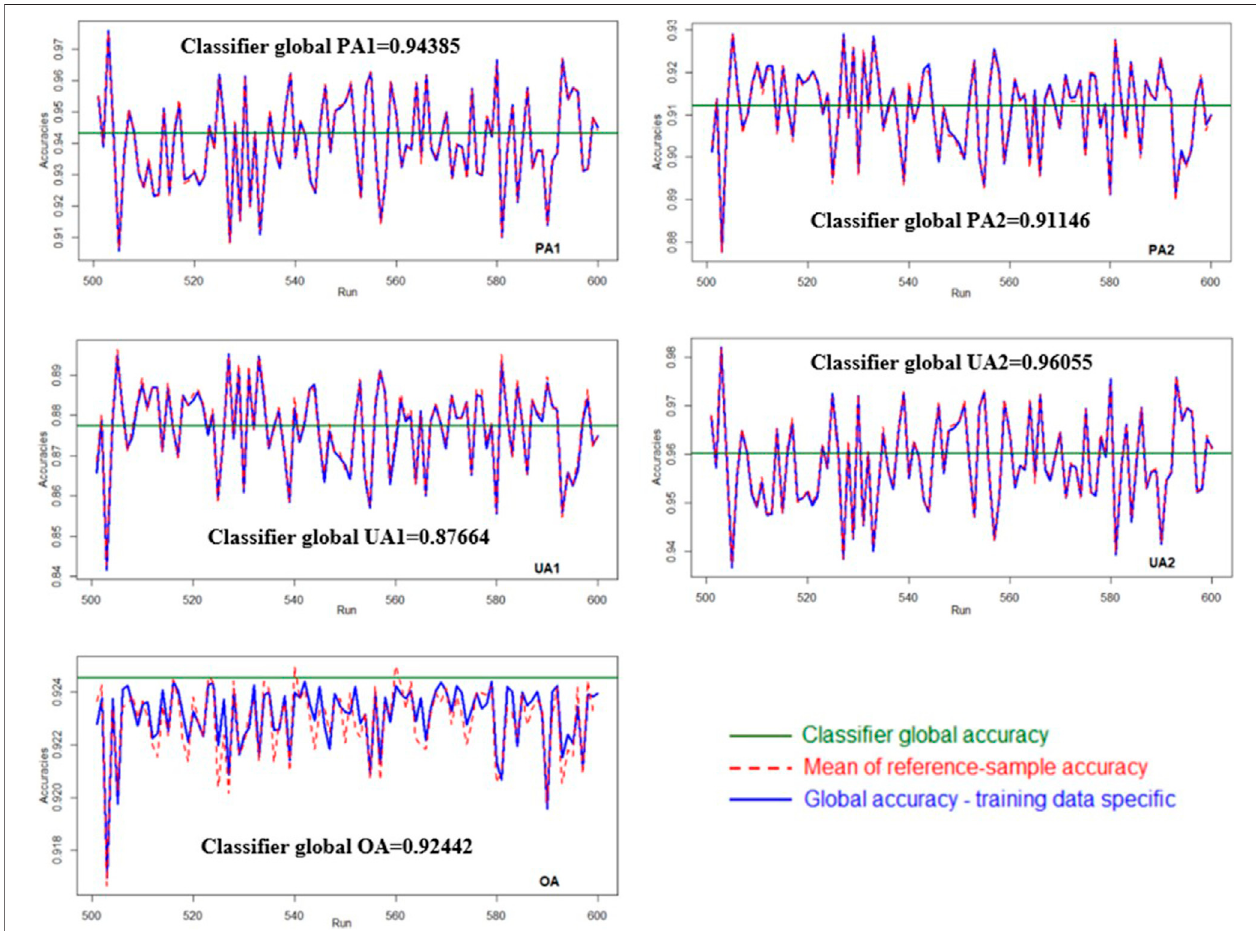
FIGURE3| Comparison ofthe meanreferencesampleaccuracy, training sample – based global accuracy, and classi fi er global accuracy. Each run corresponds to one set of training sample and 1,000 sets of reference samples.